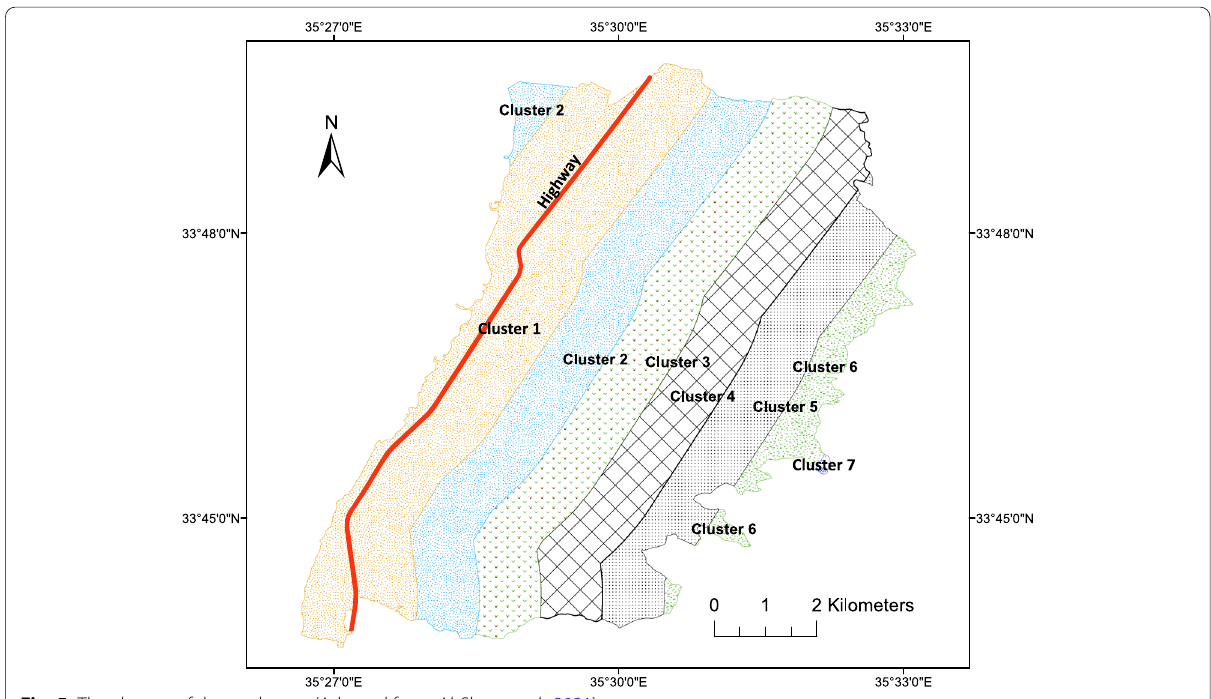
Fig. 5 The clusters of the study area (Adapted from: Al‑Shaar et al.,